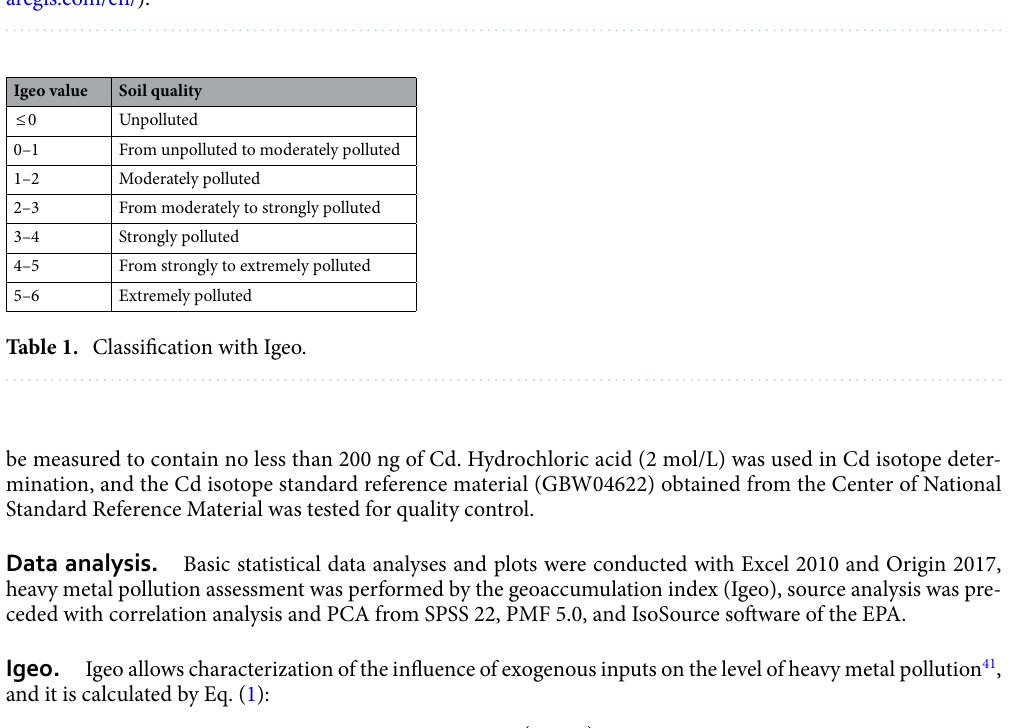
Figure 1. Sampling points in the research area of Wuqing, Tianjin (created by Arcgis 10.2, https:// deskt op. arcgis. com/ en/).